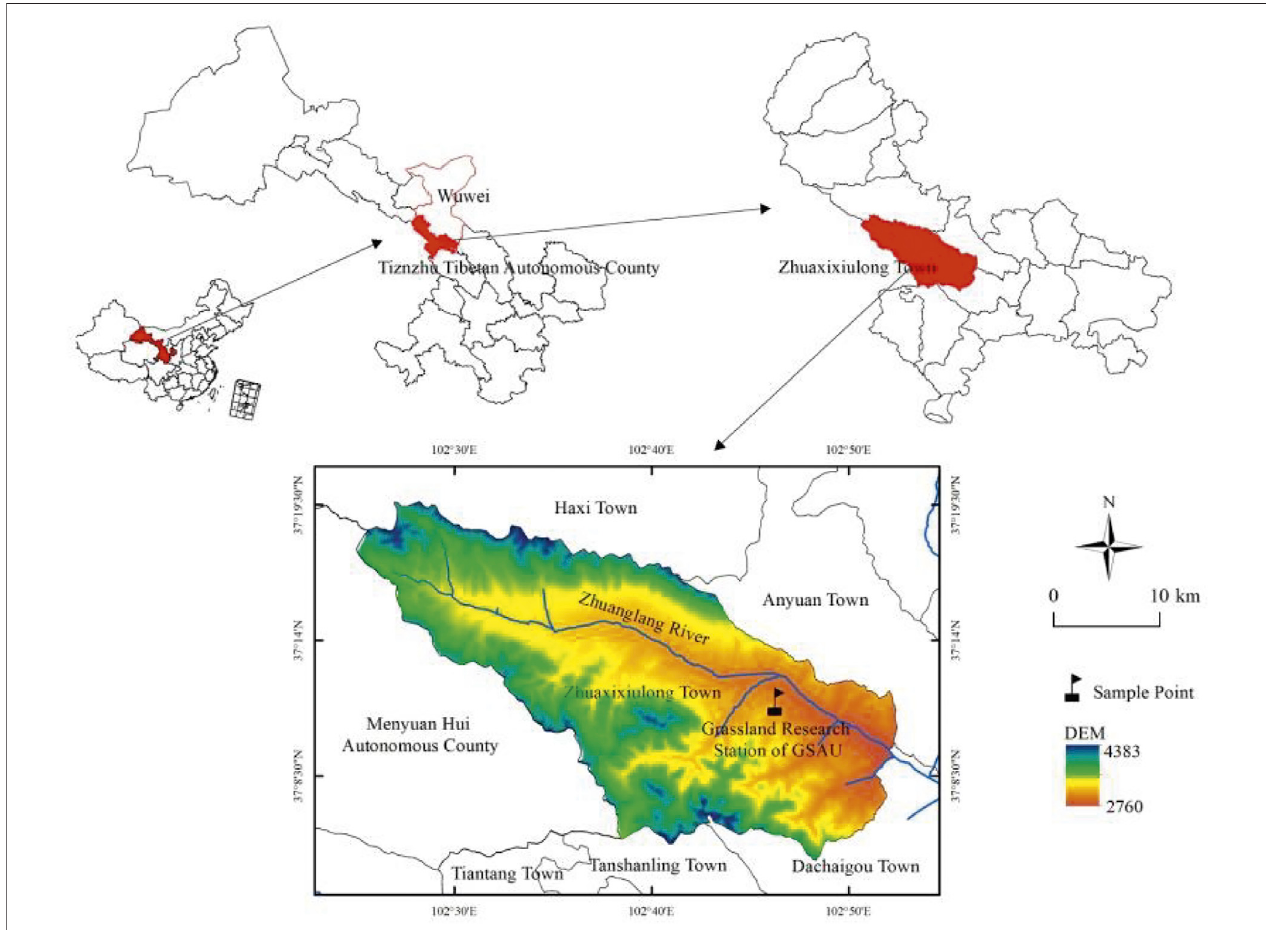
FIGURE 1 | Schematic diagram of the experimental site. *Administrative division data were obtained from the Resource and Environment Data Center of the Chinese Academy of Sciences (http://www.resdc.cn), and digital elevation model data, with a spatial resolution of 30 m, were obtained from the Geospatial Data Cloud (http://www.gscloud.cn/).